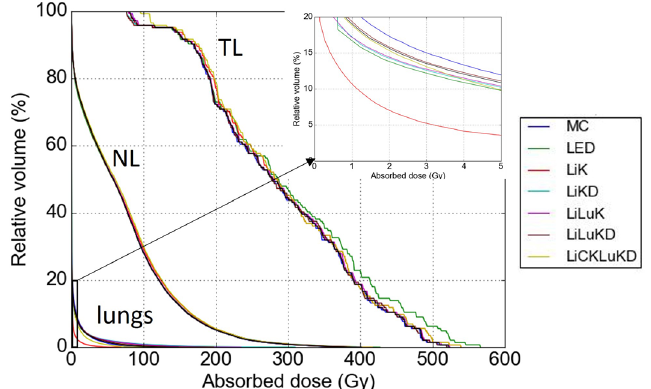
Figure 3. Cumulative DVH for NL, tumors, lungs and magnified image of lungs by MC and VSV methods for another sample patient.